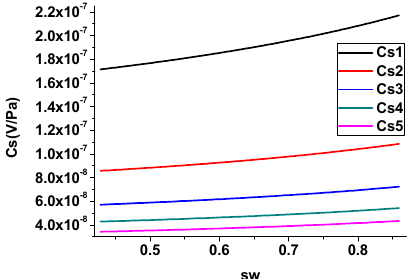
Figure 12. Influence of viscosity on streaming potential coupling coefficient (slug flow).